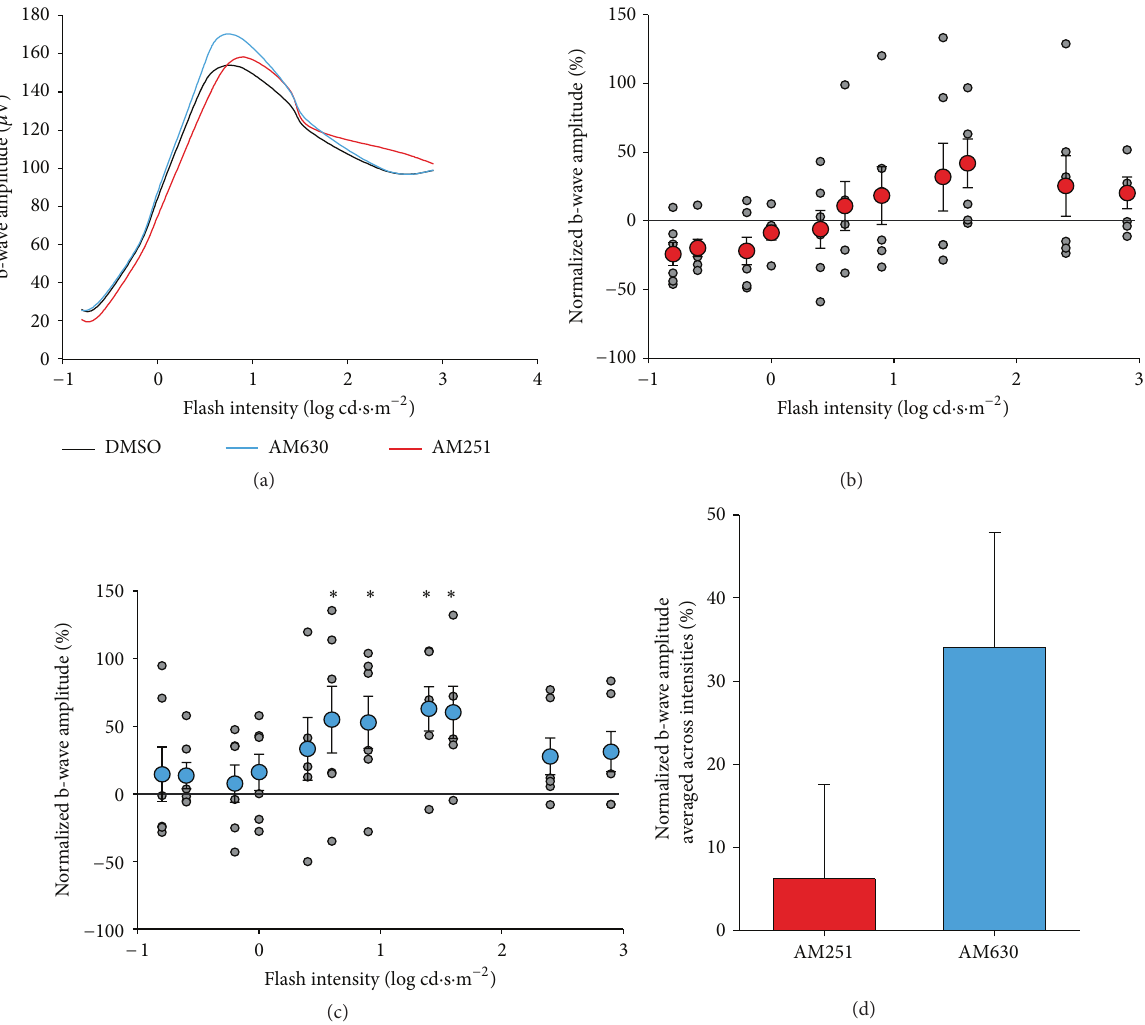
Figure 3: Photopic b-wave amplitudes. (a) Amplitudes of photopic ERG b-waves plotted as a function of flash intensities. (b) Scatter plot for normalized b-wave amplitude as a function of flash intensity in AM251-injected monkeys. Grey points indicate raw values; red data points with error bars indicate the mean and standard error of the mean. (c) Scatter plot and linear regression for normalized b-wave amplitude as a function of flash intensity in AM630-injected monkeys. Grey points indicate raw values; blue data points with error bars indicate the mean and standard error of the mean. (d) Main effect of average amplitudes across intensities in AM251 (red) or AM630 (blue) groups. ∗ 𝑝 < .05 . ( 𝑝 < .05 ) was followed up as above. Pairwise